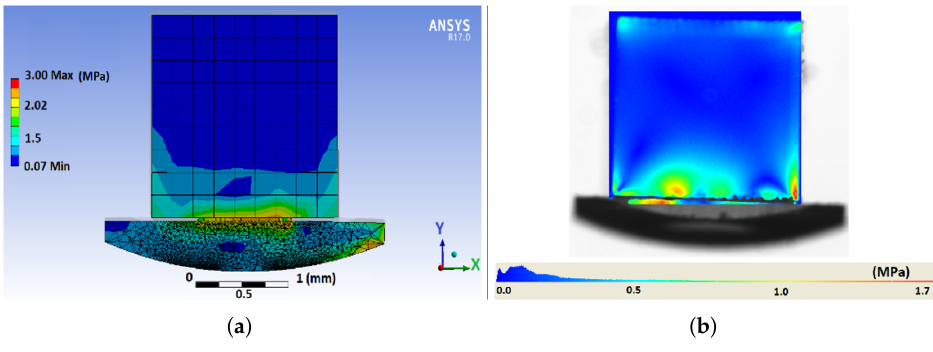
Figure 6. ( a ) Soldering-induced stress applied on components simulation results (ANSYS). ( b ) Real created stress measured with a polarimeter device after components soldering [20].